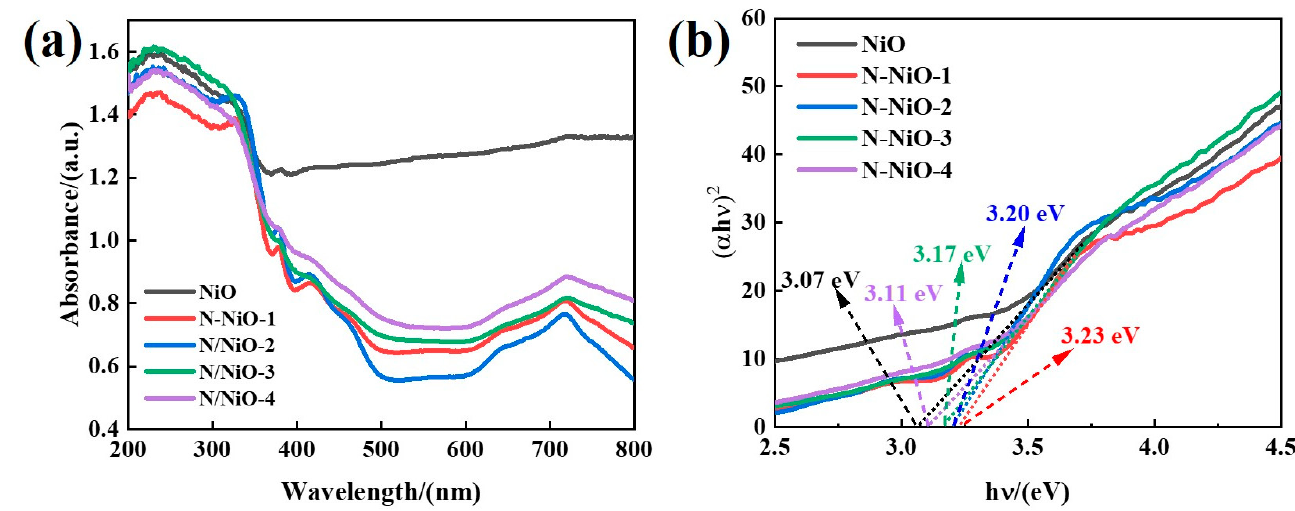
Figure 3. ( a ) Optical absorption properties of samples and ( b ) corresponding ( α h ν ) 2 -h ν